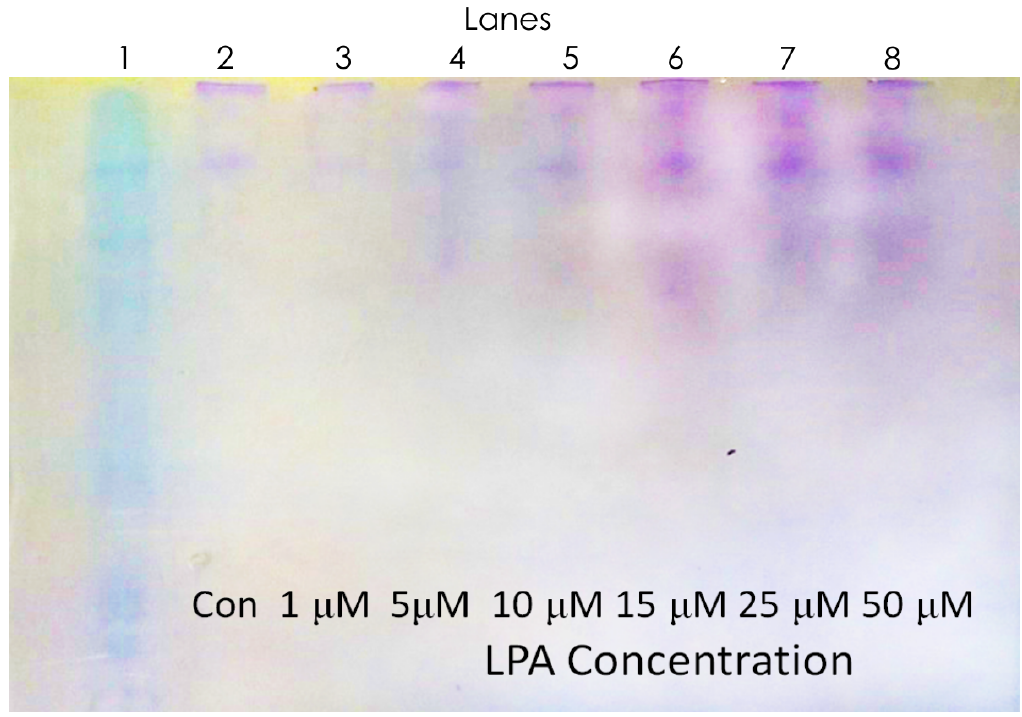
Figure 4. A non-denaturing gel where each lane contains a 1:1 mixture of gelsolin and actin that has been incubated with a varying concentration of lysophosphatidic acid (LPA).